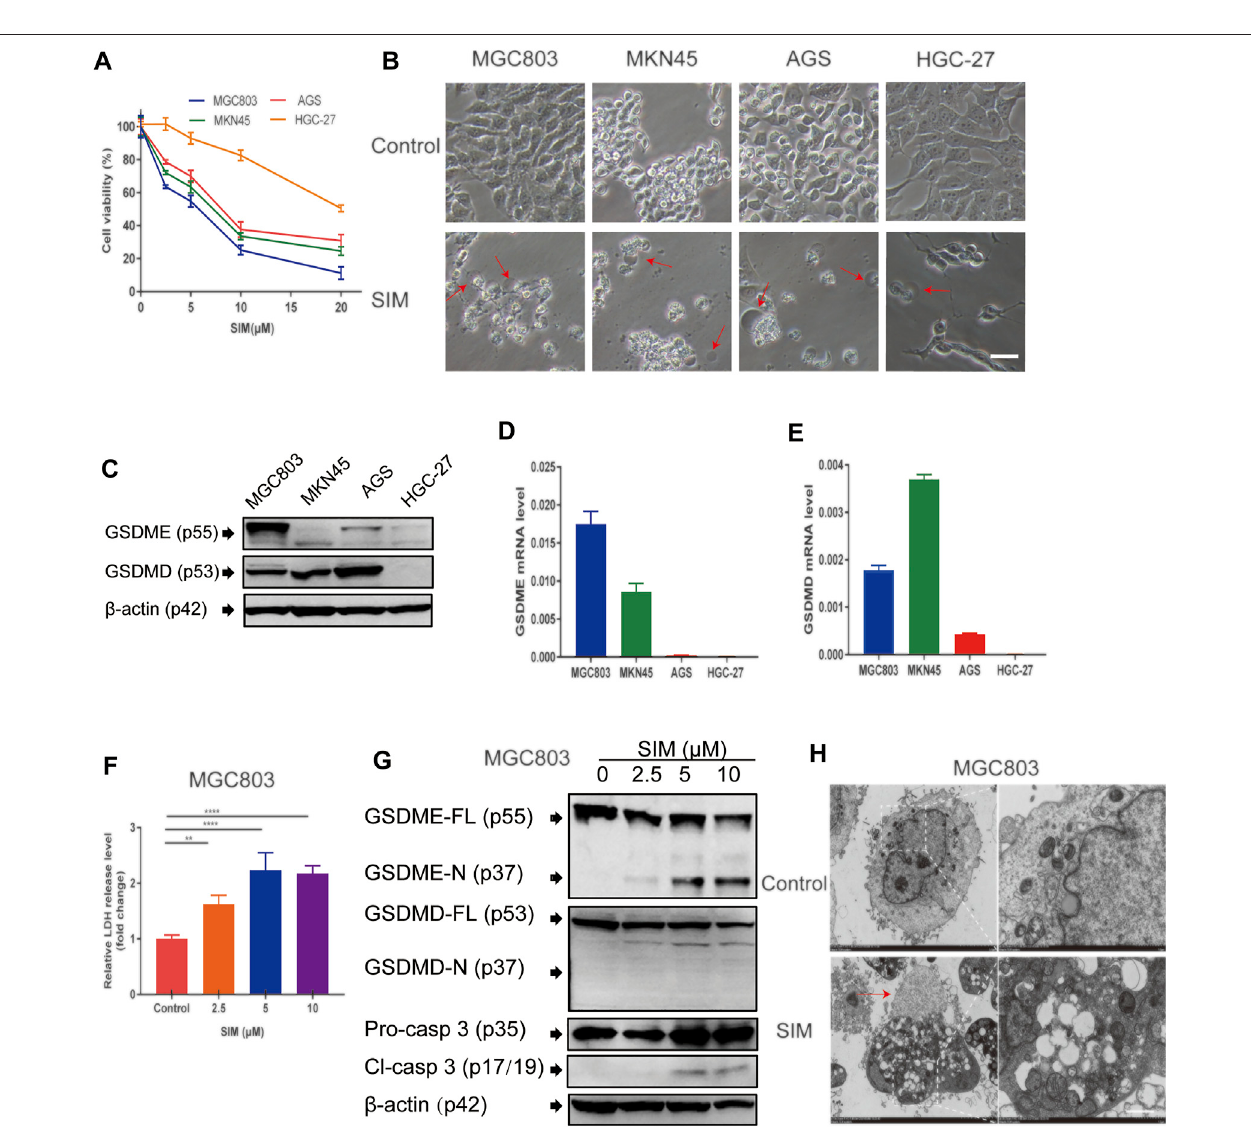
FIGURE 1 | SIM induces GSDME-dependent pyroptosis in GC cells . (A) Cell viability of four GC cell lines treated with different doses of SIM for 48 h, detected by CCK8 ( n = 3). (B) Microscopic imaging of four GC cell lines treated with SIM. Red arrows indicate ballooned cell membrane, a characteristic of pyroptotic cells; scale bar = 50 μ m. (C) Protein levels of GSDME and GSDMD in four GC cell lines, determined by Western blotting. (D,E) The mRNA expression of GSDME and GSDMD gene, detected by RT-qPCR. (F) Release of LDH into the culture supernatant, detected by LDH assay kit ( n = 4). (G) Protein levels of full length (FL) or N-terminal of GSDME and GSDMD, pro-caspase 3 (pro-casp3) and cleaved caspase-3 (Cl-casp3) of SIM-treated MGC-803 cells. (H) Electron microscopic images of MGC-803 cells treated with 5 μ M SIM for 48 h. Red arrows indicate ballooned cell membrane characteristic of pyroptotic cells; scale bar = 10 μ m. Data are shown as mean ± SD or representatives of at least three independent experiments. β -actin was used as an internal control for Western blot. pp p < 0.01, and pppp p < 0.0001.